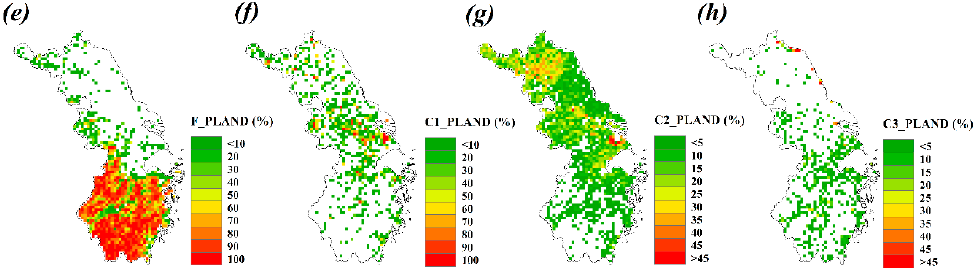
Figure 4. Landscape patterns of ( a ) PAFRAC; ( b ) IJI; ( c ) SHDI; ( d ) AI; ( e ) F_PLAND; ( f ) C1_PLAND; ( g ) C2_PLAND; and ( h ) C3_PLAND in the Yangtze River Delta.